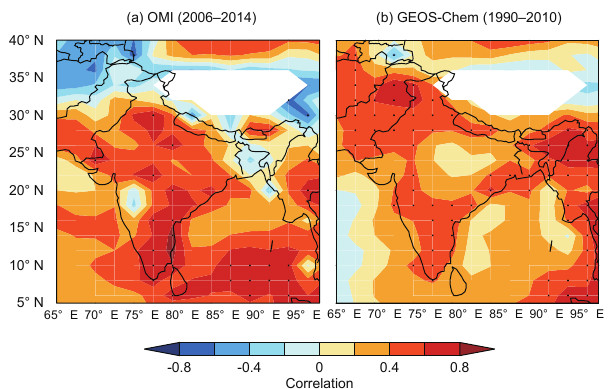
Figure 6. Spatial distribution of correlation coefficients between seasonal mean surface temperature and lower tropospheric ozone in pre-summer monsoon seasons calculated for each model grid from (a) OMI satellite observations for 2006–2014 and (b) the GEOS-Chem BASE simulation for 1990–2010. Black dots denote statistical significance ( p value <